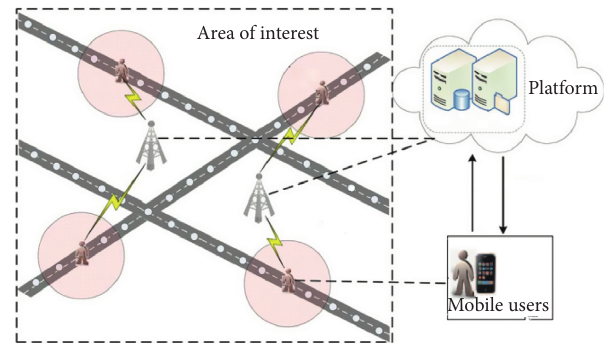
Figure 1: MCS network